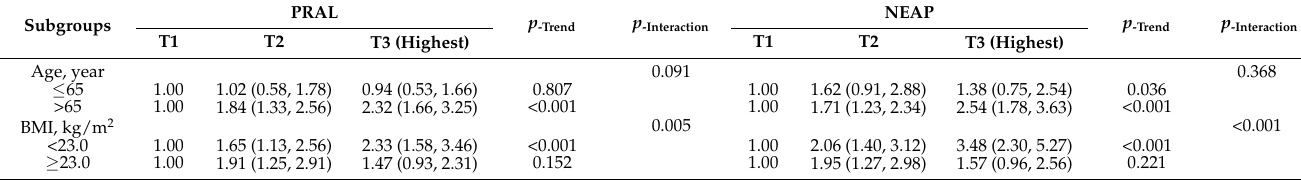
Table 4. Odds ratio (95% CIs) of hip fractures for tertiles of dietary acid load by